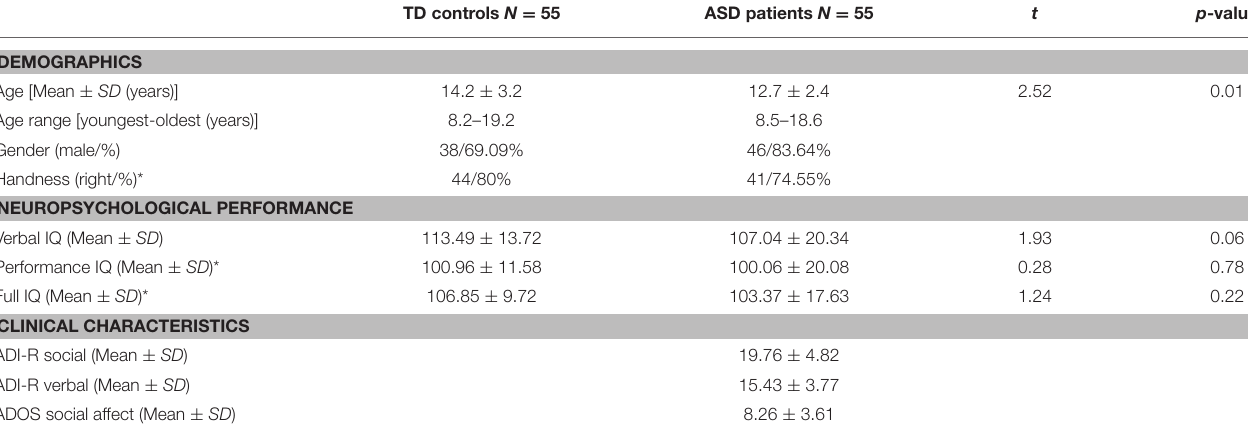
TABLE 2 | Summary of demographics, neuropsychological performance, and clinical characteristics for each of the TD and ASD groups.